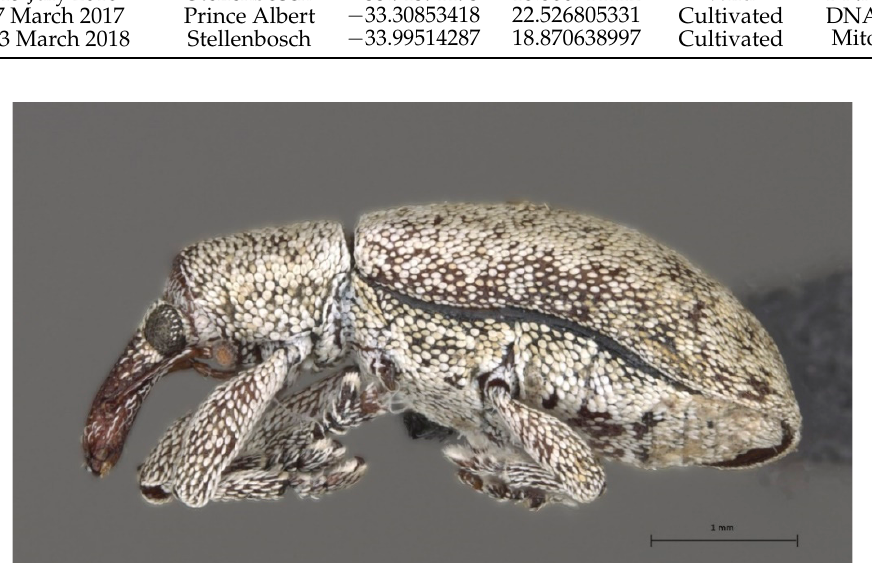
Figure 1. Anchonocranus oleae specimen collected in Grahamstown and deposited in the Iziko Museum South Africa (Cape Town), assigned with the coden SAM-COL-A082796.